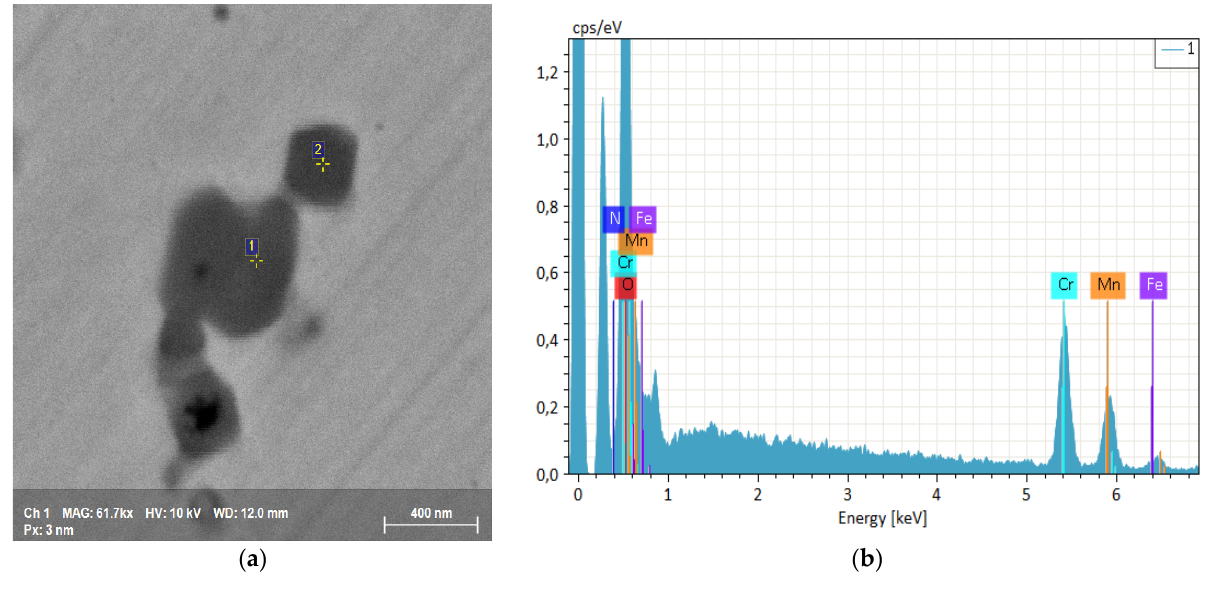
Figure 11. ( a ) SEM FEG high resolution precipitate image. ( b ) EBSD spectrum of the rounded σ